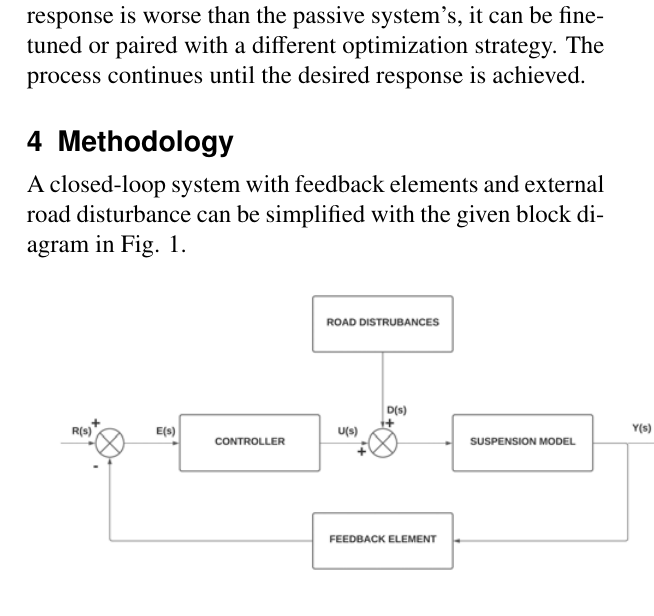
Figure 1. Block Diagram for closed loop system Vertical motions and disturbances will be detected by sen- sors positioned on the vehicle’s body. These values are sent to the controller, which will take corrective action to bring the system back into balance. The damping coe ffi - cient will be controlled directly by the controller by ma- nipulating current values into system. Fig. 2. demon- strates the dynamic model for the quarter car system.